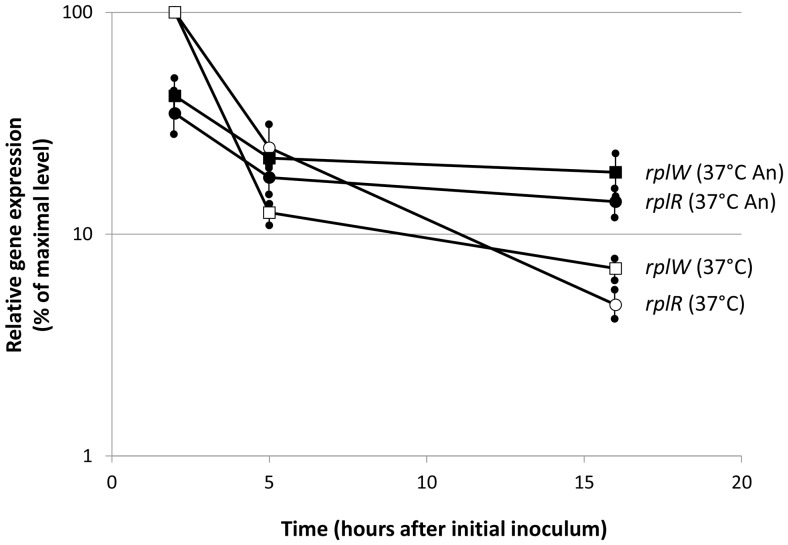
Time-course expression of ribosomal protein-encoding genes in different growth conditions.Samples were taken at 2, 5 and 16 hours from the initial inoculum at OD600 = 0.1 (see Figure S1A for comparison) and relative amounts of rplR (circles) and rplW (squares) transcripts were determined by qRT-PCR in cultures grown either aerobically (open symbols) and in oxygen limitation (closed symbols). Maximal gene expression corresponded to ΔCt values for rplR = 6.8 and for rplW = 5.5 and was set to 100%. qRT-PCR was repeated three times (with replicate samples for each experiment) on RNA obtained from a single extraction. Standard deviations are shown.